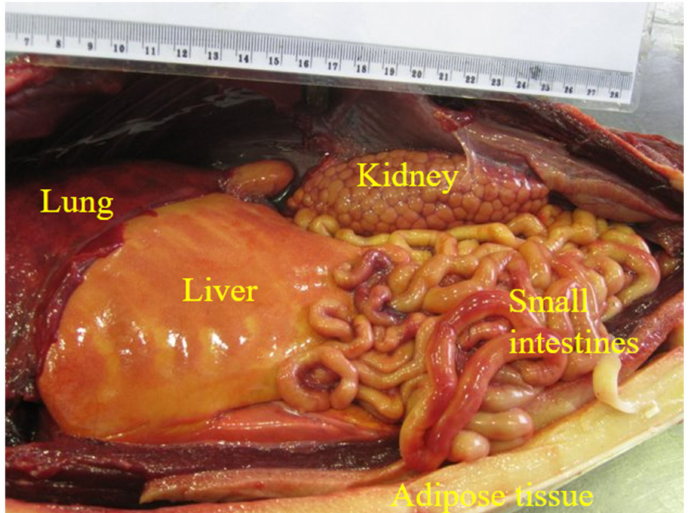
Figure 6. Neonatal male common dolphin ( Delphinus delphis ) from the Adelaide metropolitan coast of the St Vincent Gulf Bioregion, South Australia. All abdominal organs and adipose tissue were yellow in color, a sign of jaundice. Compare the color of the organs with Figure